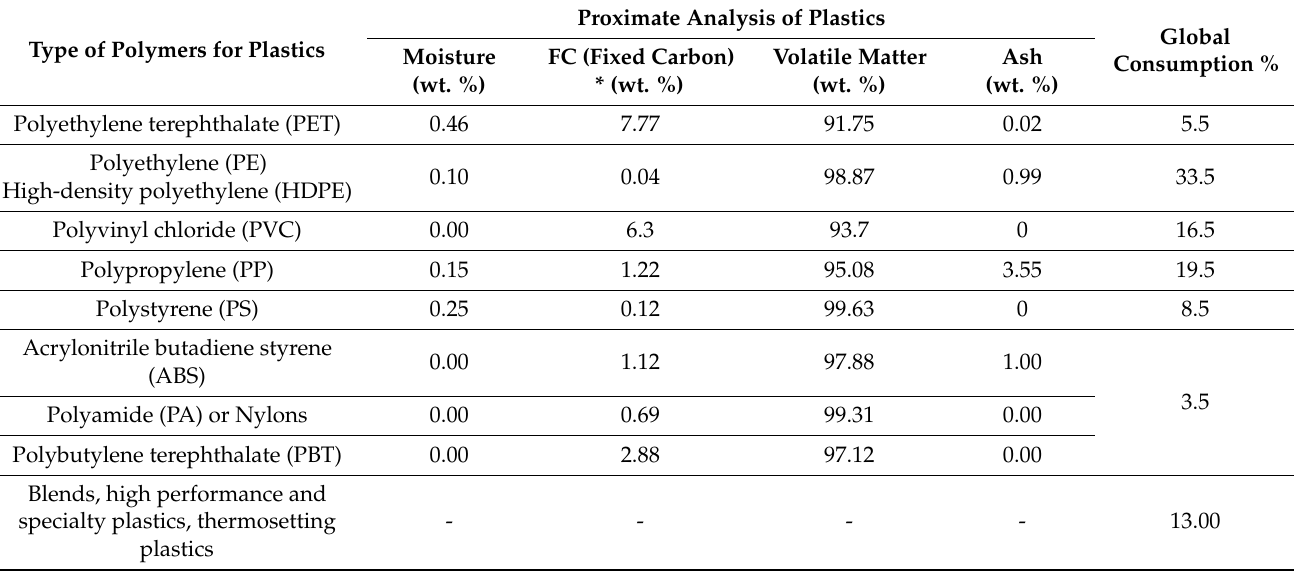
Table 2. Main plastic types, their parameters, and global consumption [33], with permission from